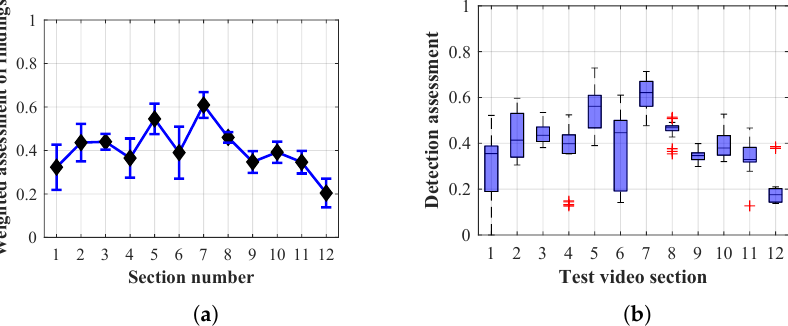
Figure 47. Results of Method 3 with a lifespan of 40 frames. ( a ) the weighted average rating with the average mean absolute error of the weighted rating and ( b ) boxplots of the distribution of the statistical sets of the results of the individual sections evaluated indicating: minimum, 1st quartile, median, 3rd quartile,